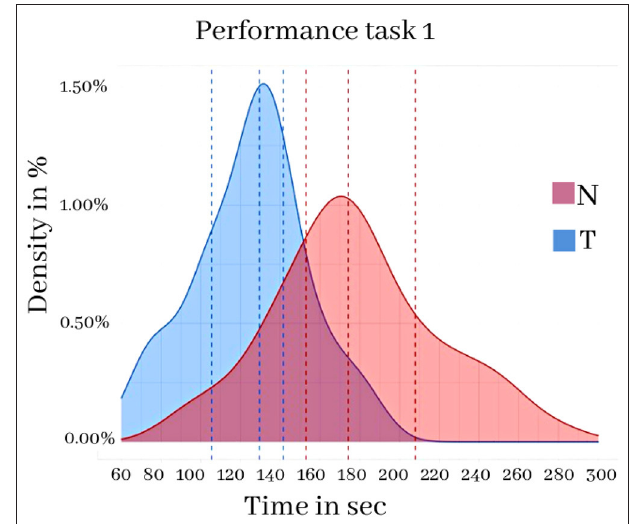
FIGURE 10 | Exploration task 1 in the two conditions N and T. Frequency distribution of the time taken to complete the task in the two conditions N and T. Vertical lines indicate the first, second and third quartiles (25%, 50%,